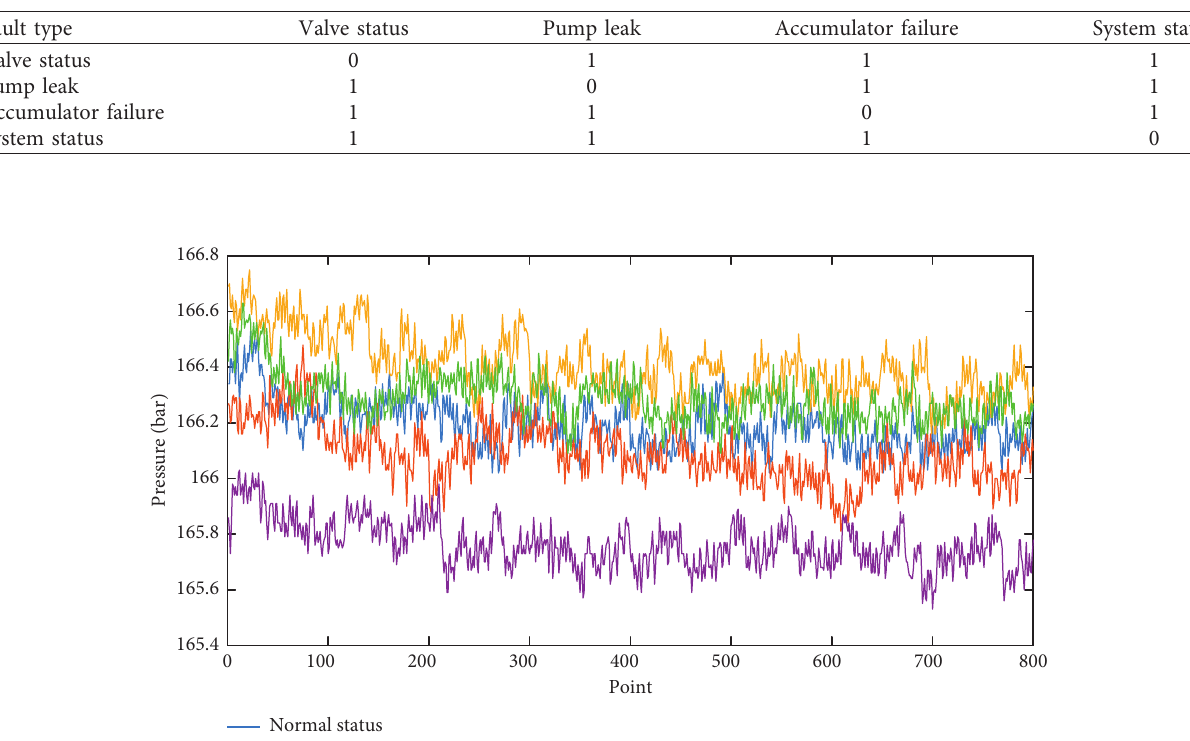
Table 2: Simulated fault information.